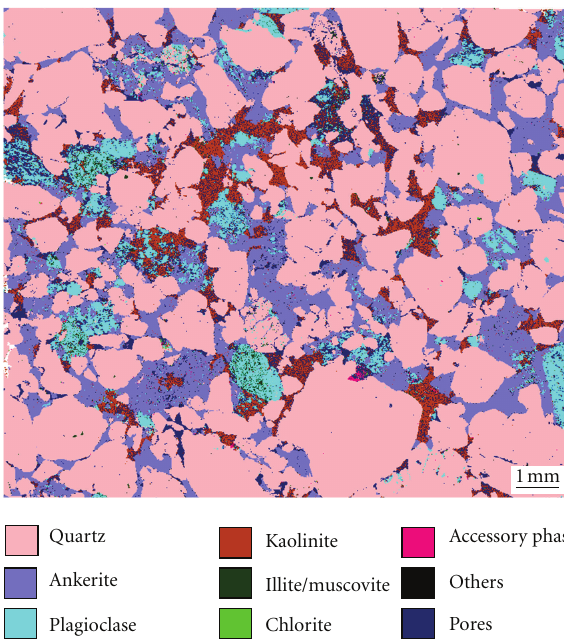
Figure 1: QEMSCAN image from the cemented zone.